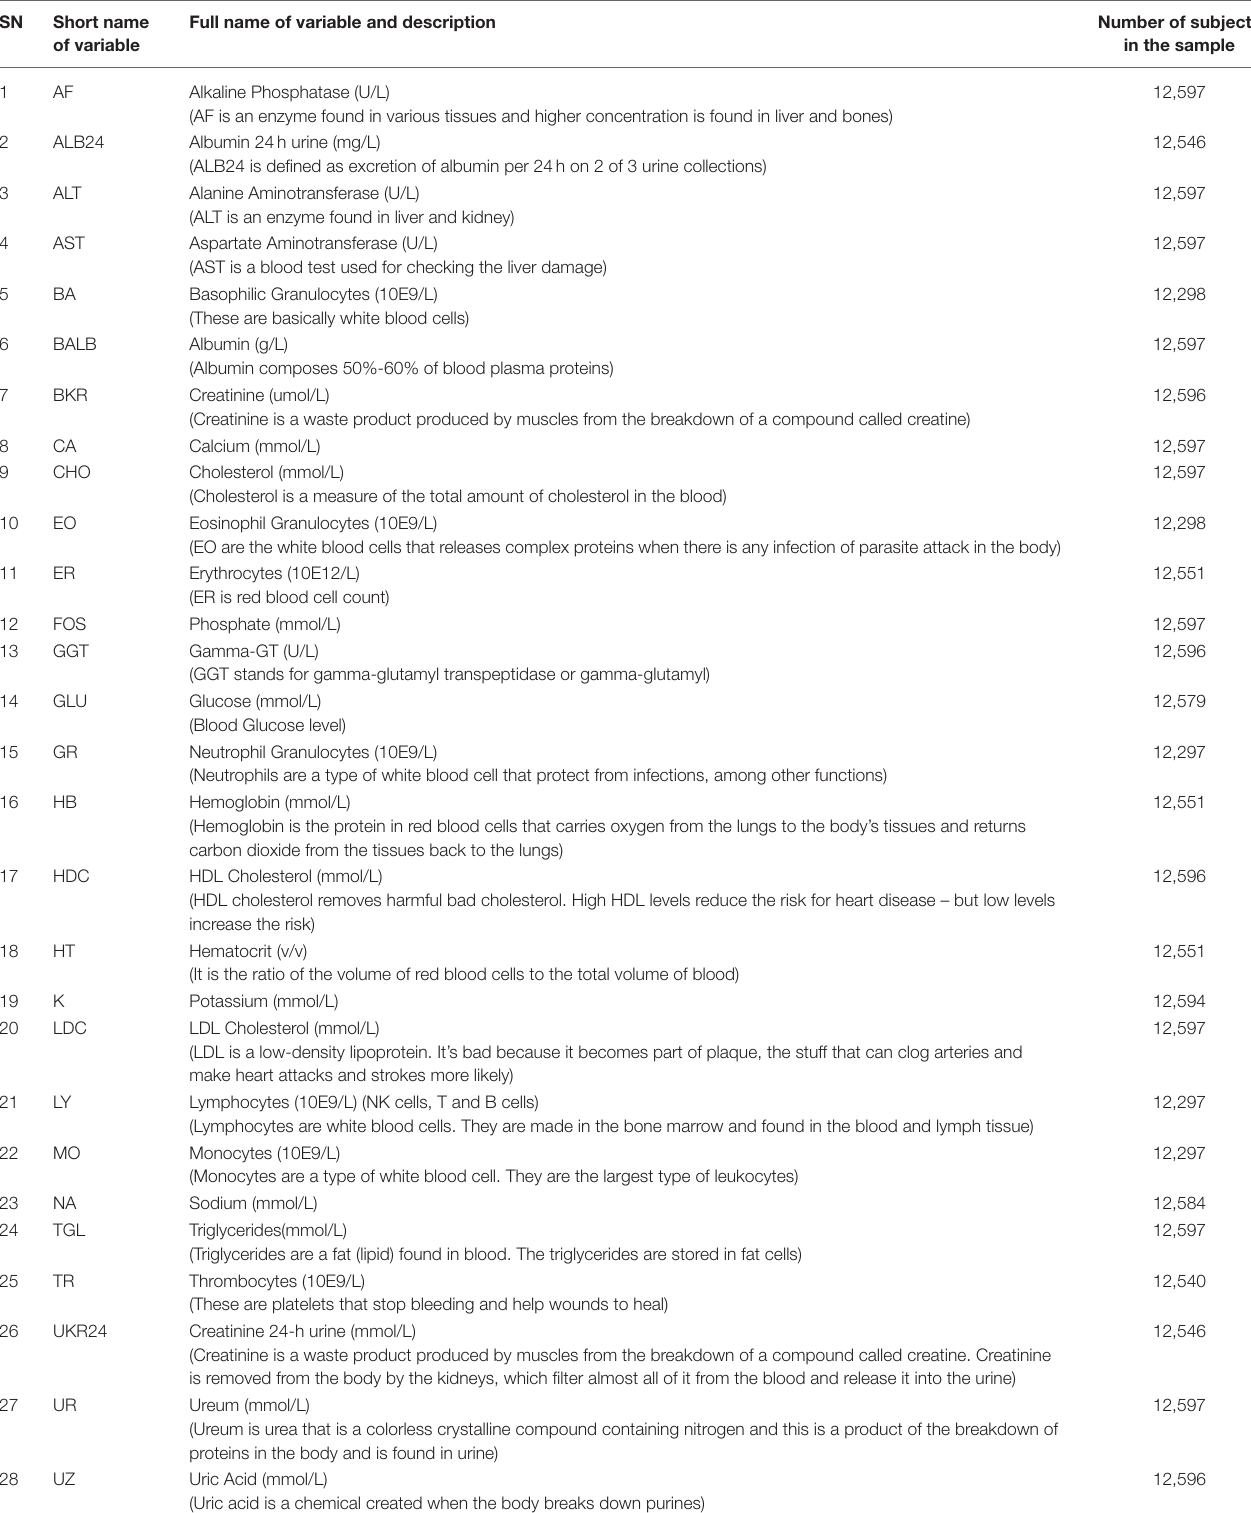
TABLE 1 | Biomarker variables of